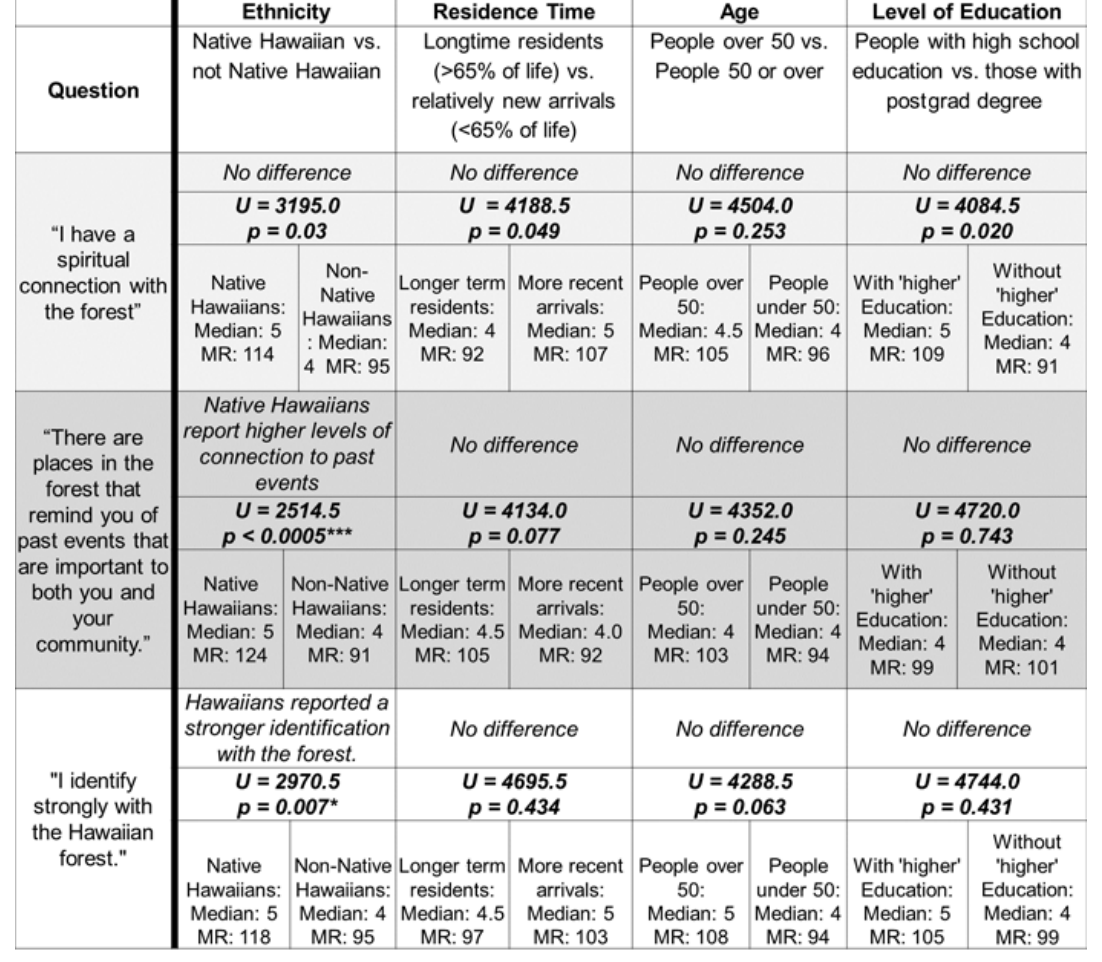
Fig. 2 . Results of comparisons of survey respondents grouped by different characteristics of their backgrounds. Significance values (p-values) are provided before the Bonferroni correction. Main findings are in italics. *** p